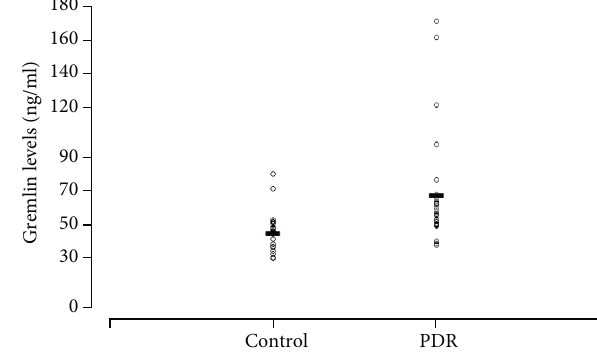
Figure 2: Scatter plot showed the levels of gremlin in the vitreous from the eyes with proliferative diabetic retinopathy (PDR, n = 26 ) and idiopathic epiretinal membrane (control samples, n = 22 ). Open circles represent the vitreous levels of gremlin. The horizontal lines indicate the mean concentration of gremlin in each